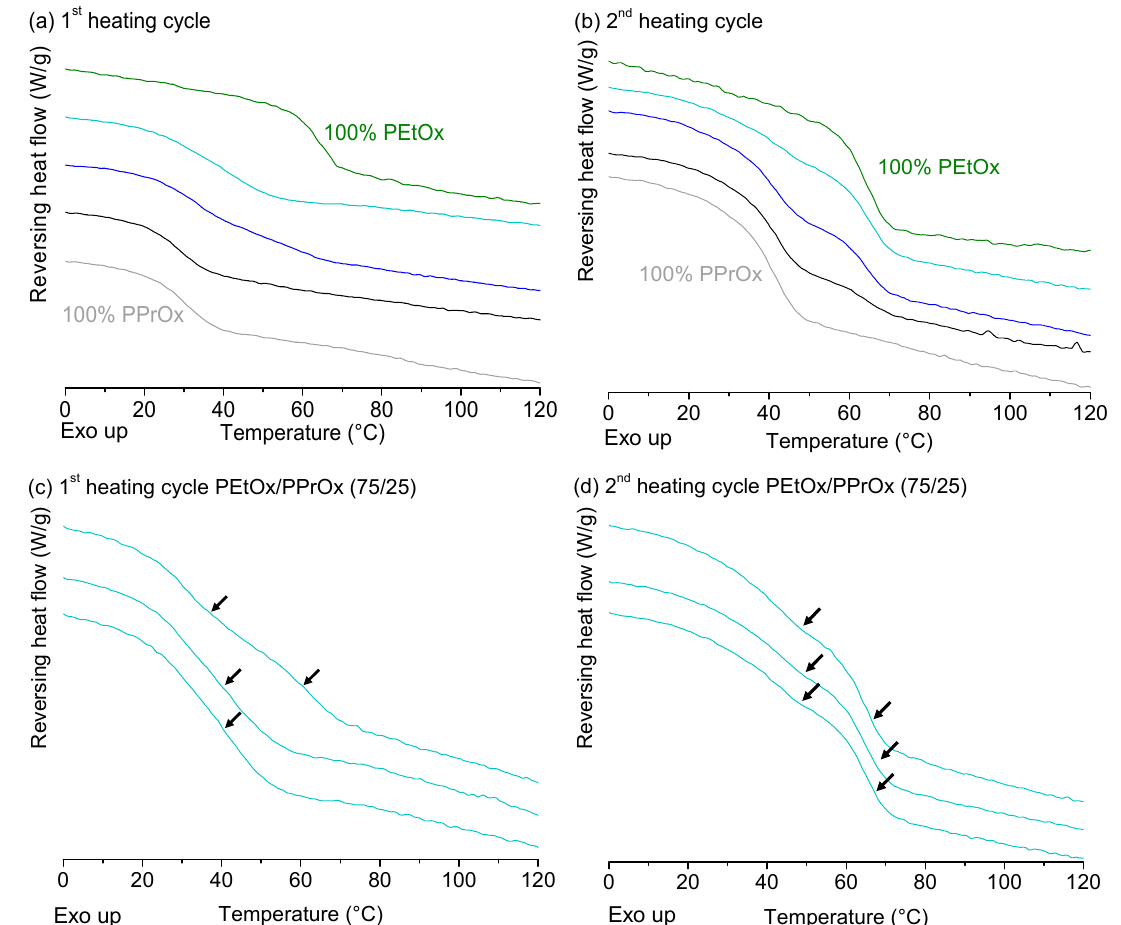
Figure 6. First ( a ) and second ( b ) heating cycle of spray dried PEtOx (green), PEtOx / PPrOx 3 / 1 ( m / m ) (cyan), PEtOx / PPrOx 1 / 1 ( m / m ) (blue), PEtOx / PPrOX 1 / 3 ( m / m ) (black) and PPrOx (grey). The three measurements that were performed for the blend consisting of 75% PEtOx and 25% PPrOx (% m / m ) are displayed in ( c , d ). There was clearly inhomogeneity in the sample as demonstrated in the first heating cycle ( c ). In the second heating cycle ( d ) all three measurements showed a similar mDSC thermogram with two T g s at the same positions for all three measurements. Average T g values ( n = 3) can be found in Supplementary Materials S2a. Created with Origin 8.5 from OriginLab (Northampton, MA, USA).